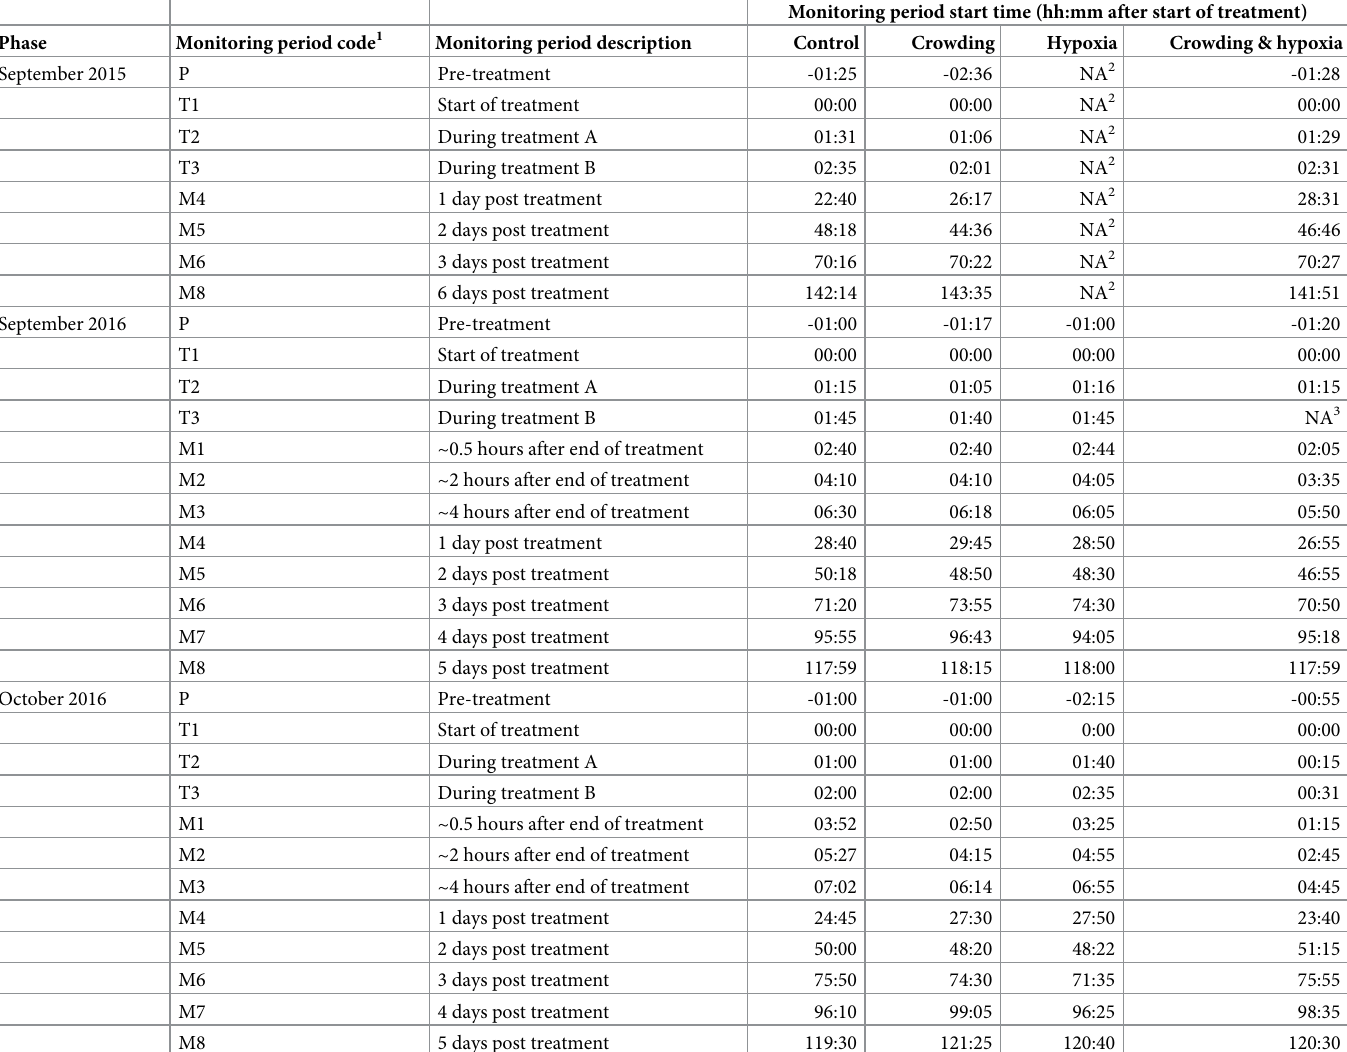
Monitoring period start time (hh:mm after start of treatment)